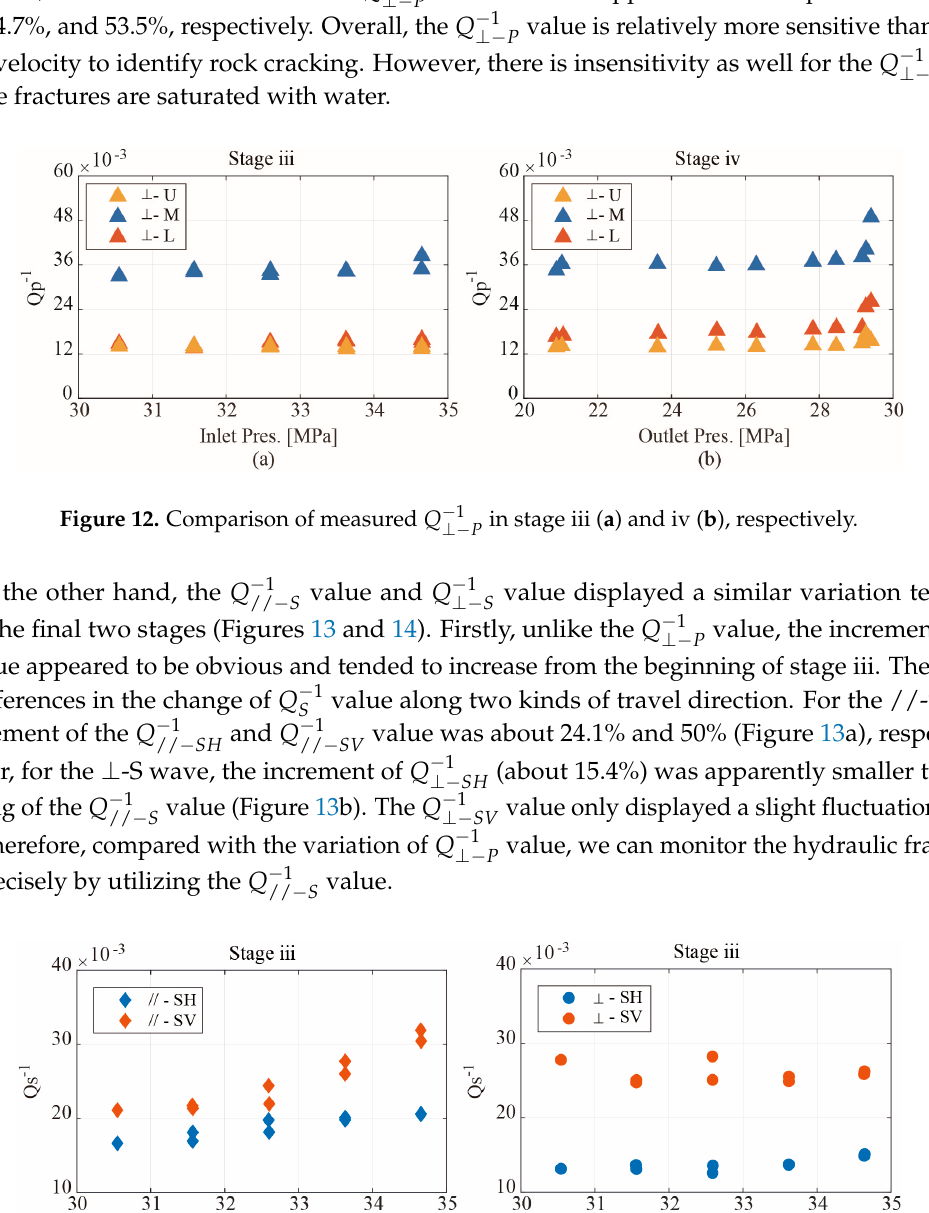
− 1 ( a ) and Q − 1 ⊥− ( b ) in stage iii, S // − S